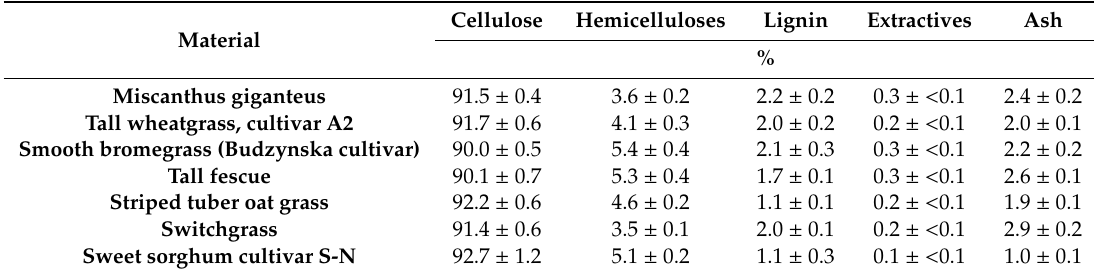
Table 3. Chemical composition of cellulosic